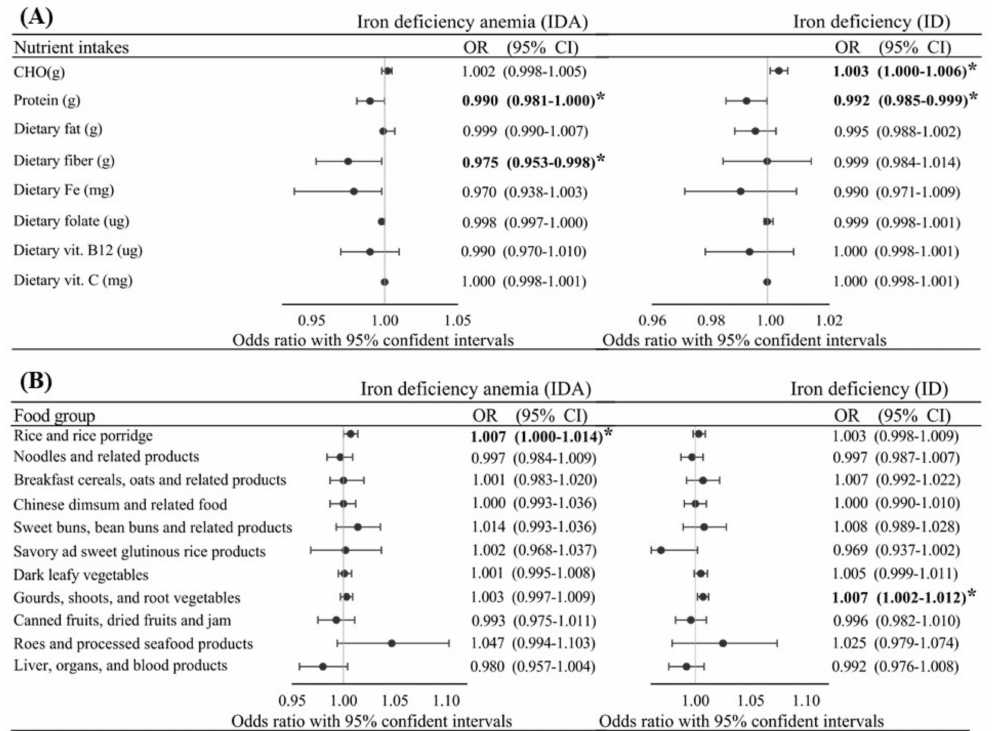
Figure 1. Adjusted odds ratio (OR) and 95% confidence intervals (CI) of gestational iron deficiency (ID) and ID anemia (IDA) with various intake levels of nutrients ( A ) and foods ( B ) among all pregnant women after adjusting for age, pre-pregnancy body-mass index, region, parity, total supplement use (%), and trimester. p value/ p for trend as * p ≤